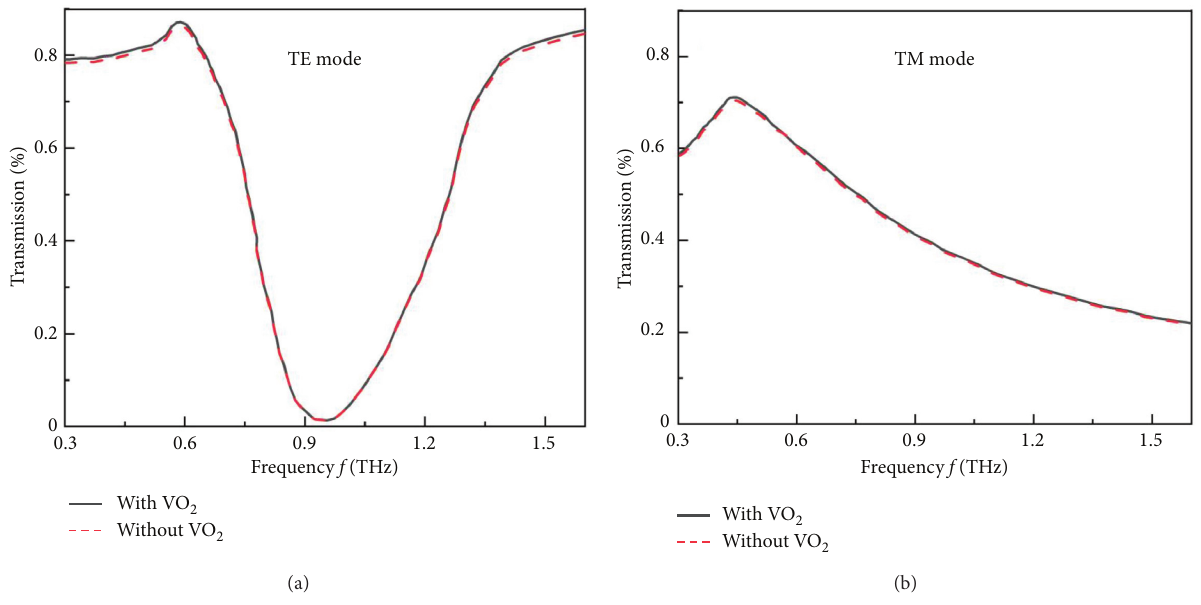
Figure 2: Influence of VO 2 on the transmission spectrum of the device under (a) TE mode and (b) TM